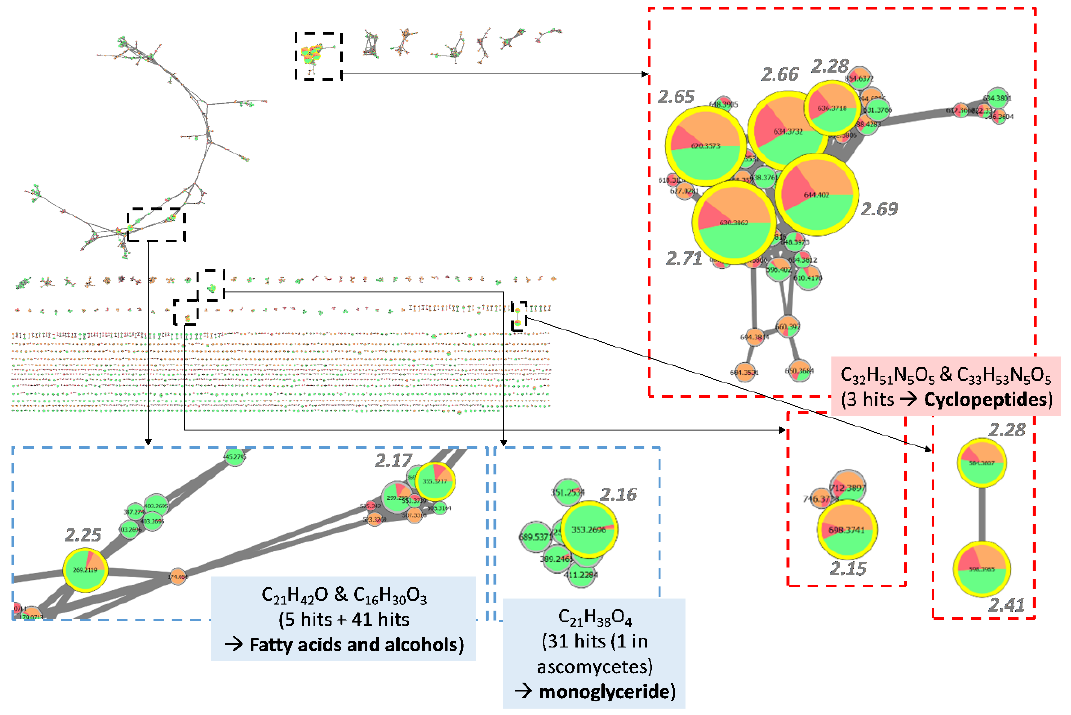
Figure 4. Feature-based molecular network corresponding to Biscogniauxia extracts. Nodes are filled with pie charts representing the mean peak areas for each feature in the 3 defined groups of activity (anti-maturation activity at 200 µg/mL in 48 h): low (red) for 0–30%, medium (orange) for 30–50% and high (green) for 50–100%. Node sizes are related to FiBiCo scores indicated in grey, highlighting compounds mostly linked to the activity observed.